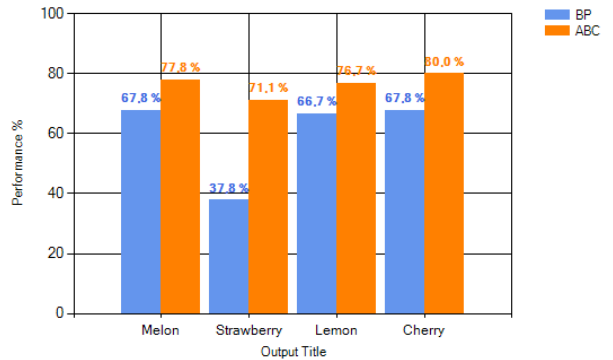
Figure 6. Performances of BP and ABC algorithms on test dataset.